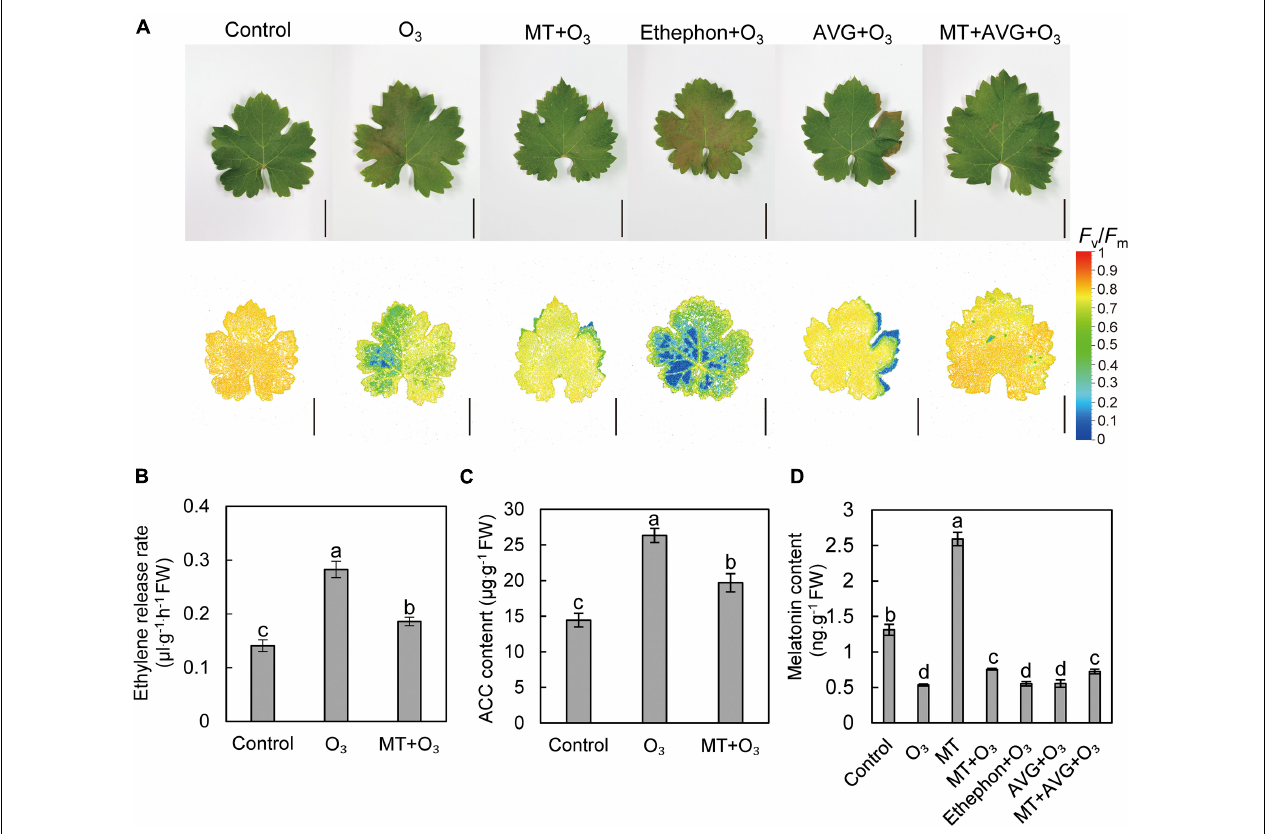
FIGURE 2 | Effects of MT and ethylene on the apparent symptoms and chlorophyll fluorescence (A) , ethylene release rate (B) , ACC (C) , and MT (D) contents in grape leaves after O